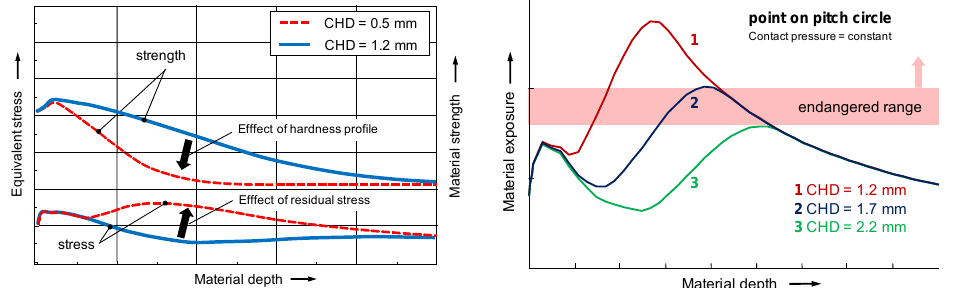
Figure 7. Exemplary influence of varying case hardening depth on the material strength (left), equivalent stress (left) and material exposure as a function of depth indicating the risk of sub ‐ surface overloading (right) [7].